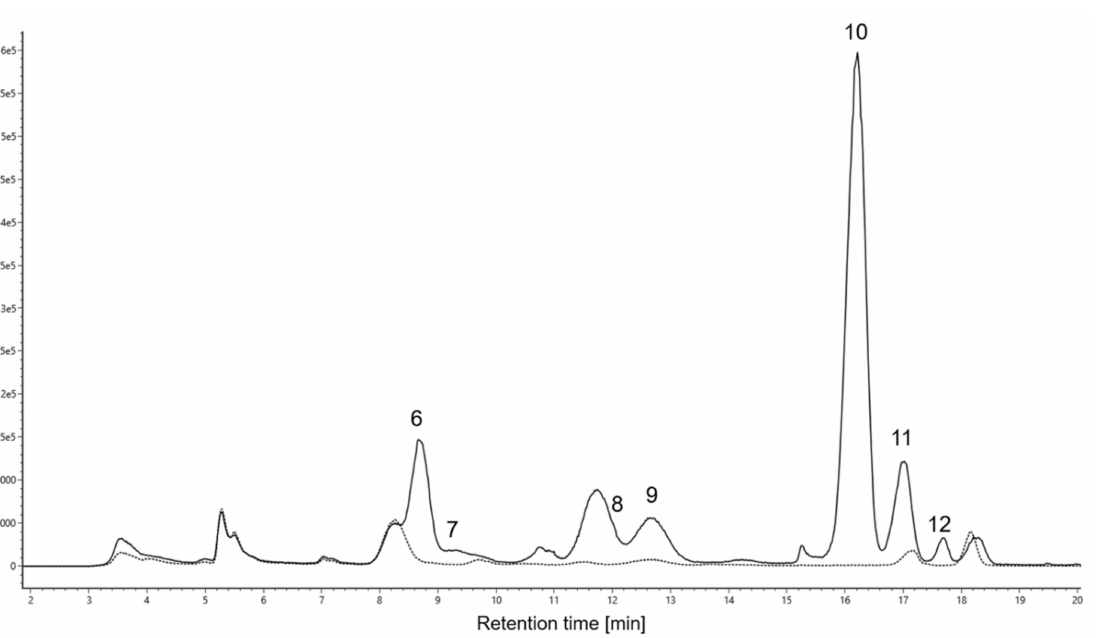
Figure 4. Extracted ion chromatograms of the [M] + , m / z 529.0646 (black line) and 609.0215 (dashed line) (cyanidin-3- O - glucoside mono- and disulfate) after the synthesis